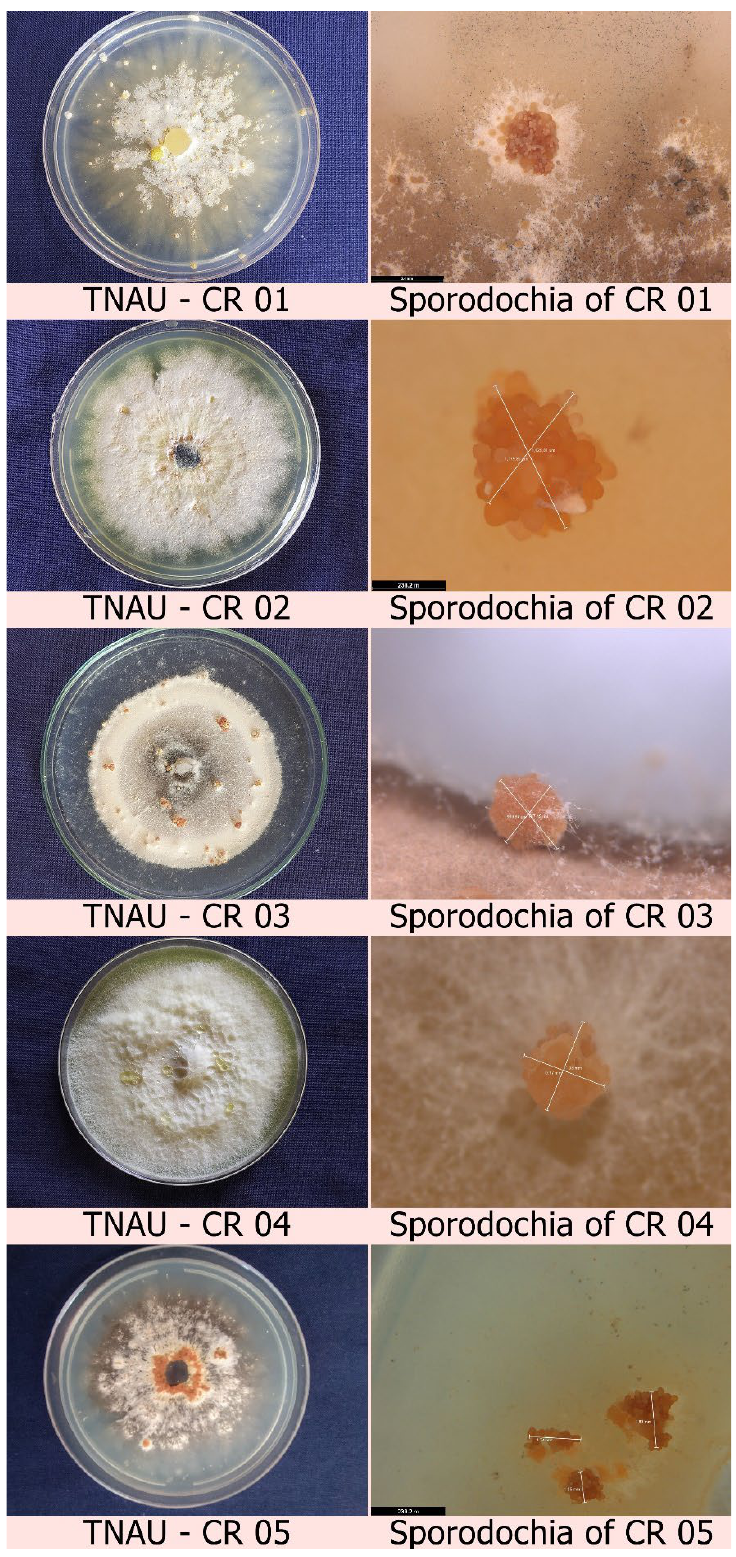
Figure 1. Colony morphology and sporodochial characteristics of all five C. rosea